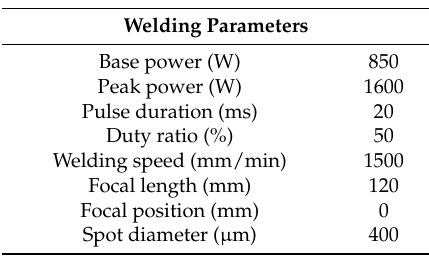
Table 2. Laser welding parameters used to join the BTi-6431S titanium alloy.